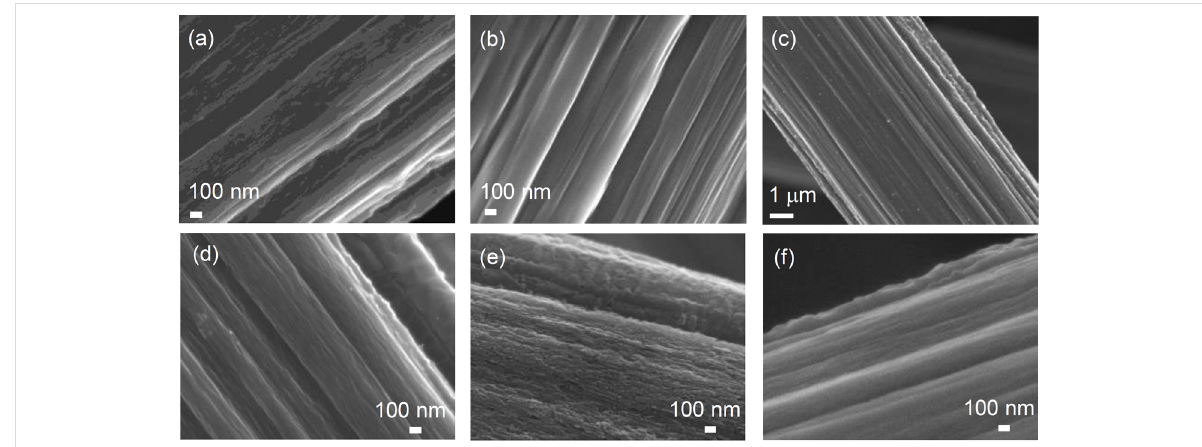
Figure 1: FESEM images of (a) TGP, (b) TGP-CSnPc, (c) TGP-CSnPc-550Air, (d) magnified view of (c), and (e) TGP-CSnPc-650Air. FESEM image of TGP-550Air (f) is also shown for comparison. FESEM images of TGP-CSnPc- T Air ( T = 500, 550, 600 and 650 °C) are shown in Figure S2 (Sup- porting Information File 1).